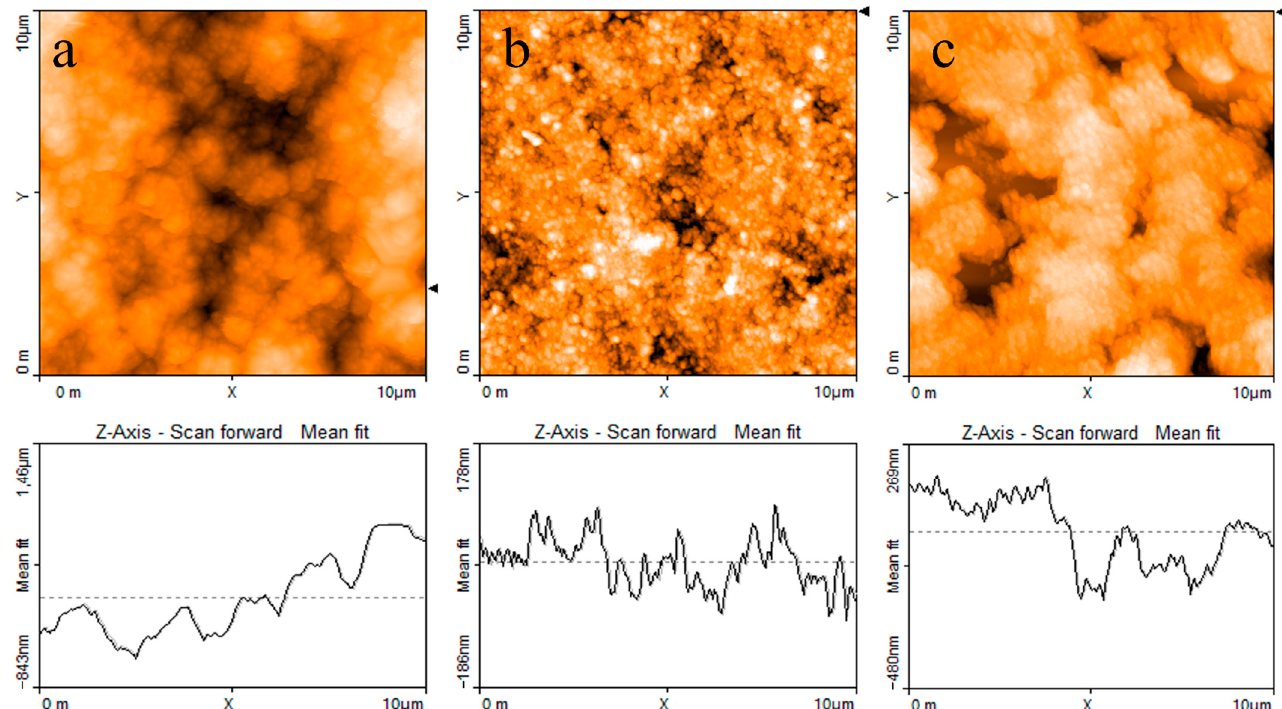
Figure 4. AFM images and line profiles ( a ) of the PPy powder; ( b ) a PPy:DBSA film deposited from an ink containing PPy and DBSA; ( c ) and PPy-GNP:DBSA film deposited from the ink containing both PPy and GNP. The triangular markers at the right side of each micrograph identify the position of the horizontal line along which the thickness profiles (reported at the bottom of each micrograph) are measured.